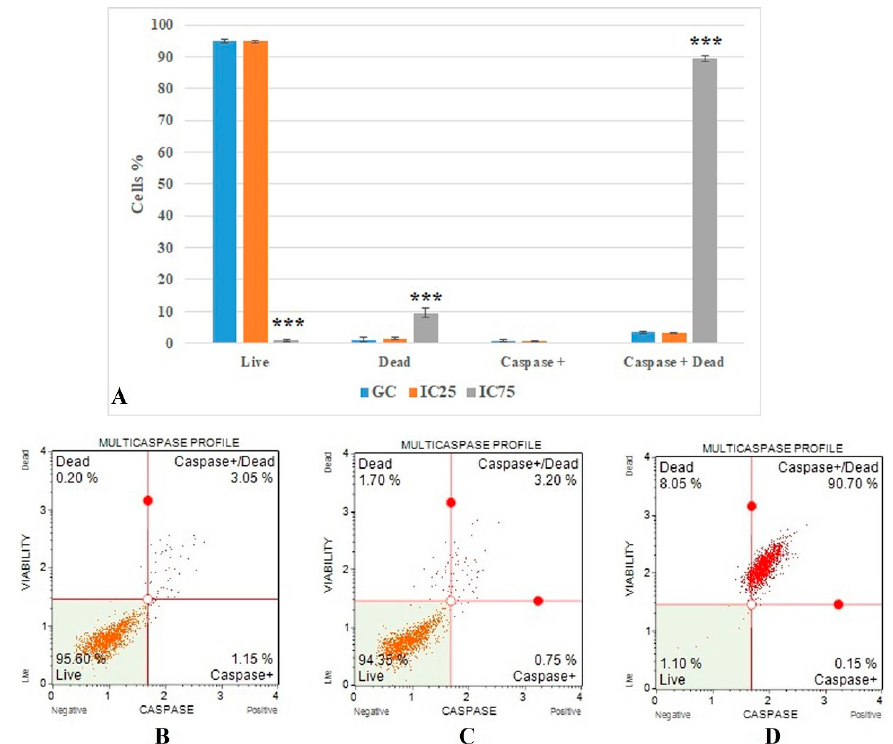
Figure 6. ( A ) Results of cell death mode from multicaspase analysis. GC: growth control. Data rep ‐ resent the average value of three independent multicaspase analyses. Error bars: the standard devi ‐ ation of the mean. Asterisk: significantly different from the control (***: p < 0.001). ( B – D ): Sample plots to multicaspase analysis from Muse Cell Analyzer. ( B ) Growth control; ( C ) IC25; ( D ) IC75. 3.5. Cell Cycle Arrested Analysis The flow cytometric cell cycle analysis results were based on DNA content profile (Figure 7) and show that the IC75 concentration of Fe ‐ Ni ANPs maintains 88.633 ± 1.001 percent of cells at the G0/G1 stage. The same value was 46.933 ± 0.321 for the growth con ‐ trol group. Versus the growth control group, the IC75 concentration of Fe ‐ Ni ANPs in ‐ creased the G0/G1 cell ratio in a statistically significant way ( p < 0.001).